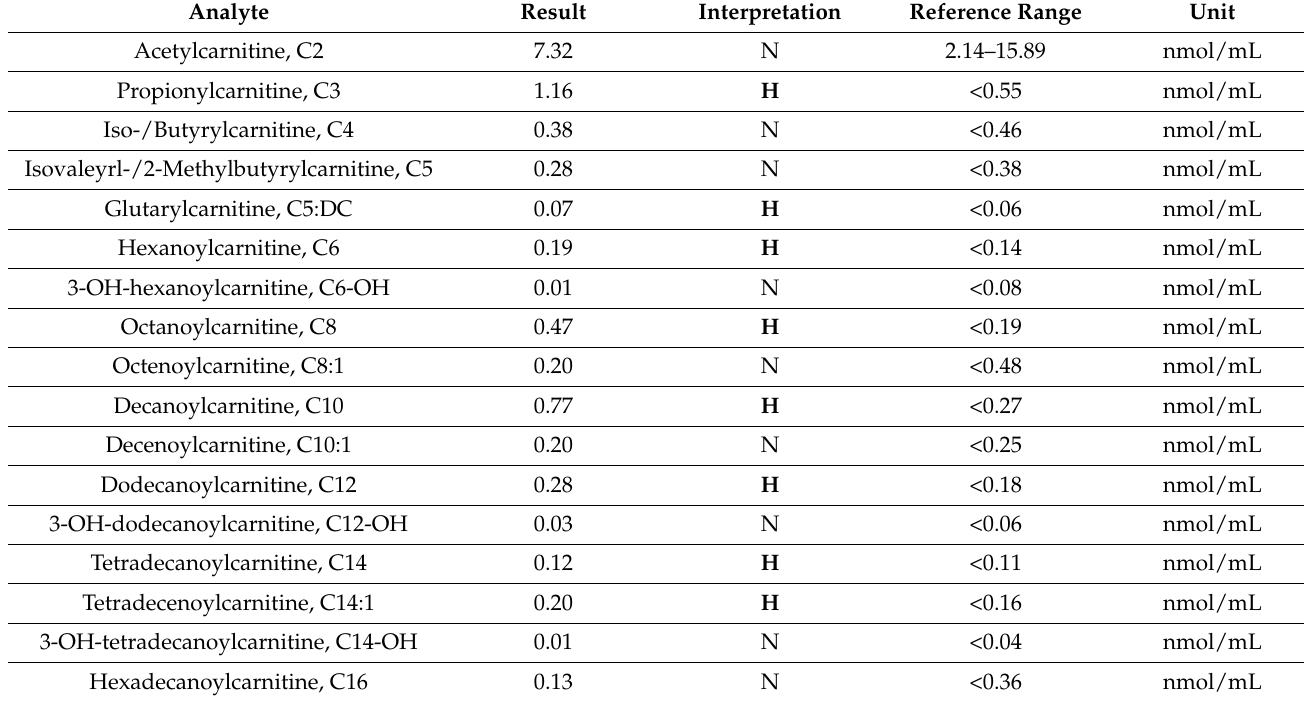
Table 1. Quantitative acylcarnitine profile of the